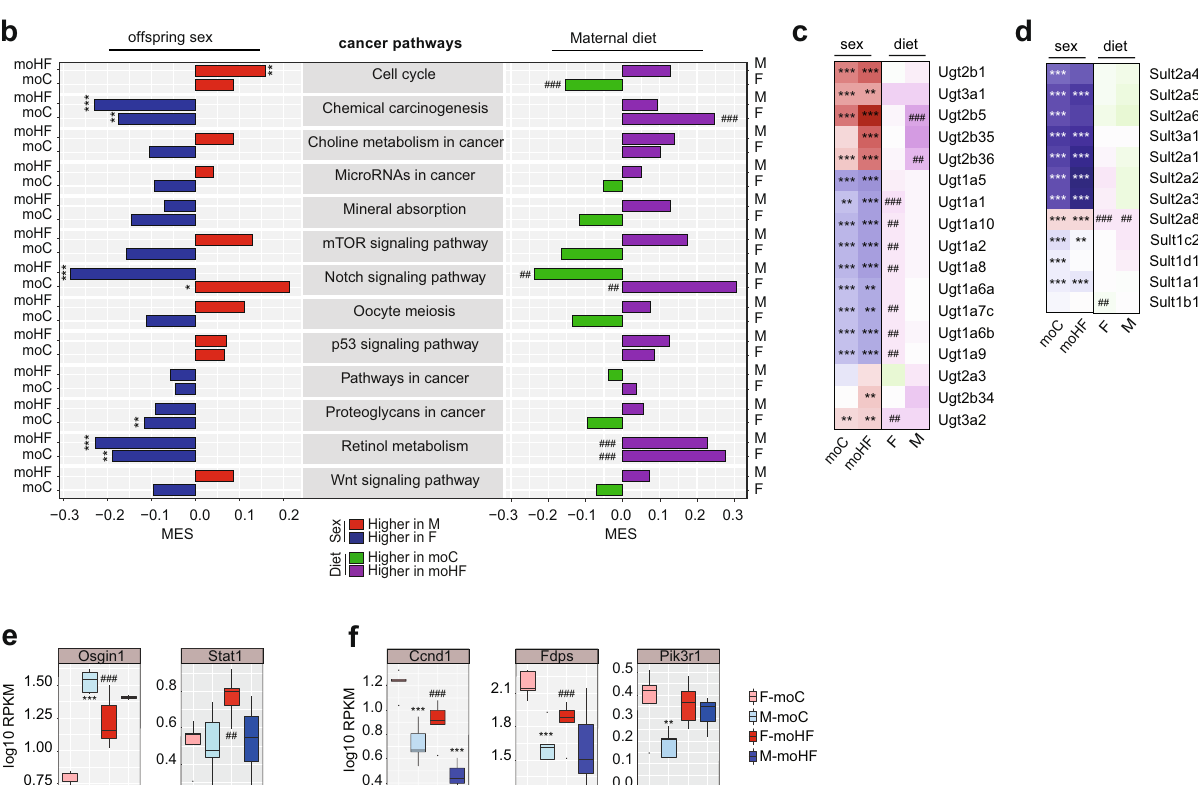
Fig. 5 Maternal obesity has sex-dependent effects on hepatocarcinoma progression in obese offspring. a 10x and 40x hematoxylin-eosin (H&E) images from liver sections of F-moC, M-moC, F-moHF, and M-moHF. b Bar plot presenting the MES between sexes in moC and moHF (left panel) and in response to MO in F and M (right panel) of the KEGG pathways involved in hepatocellular carcinoma. Red and blue bars indicate higher expression in M and F respectively and, green and purple bars indicate higher expression in moC and moHF, respectively. Heatmap of the log2 fold change expression levels of the c Ugt - gene family and d Sult - gene family; e , f Box plots showing expression (RPKM, log10) of genes involved in the nominated cancer pathways. For a , F-moC ( n = 3), M-moC ( n = 3), F-momHF ( n = 4) and M-moHF ( n = 2). For b – f , F-moC ( n = 5), M-moC ( n = 5), F-moHF ( n = 6), and M-moHF ( n = 3). For e , f , data are presented as mean ± sd. Differences between two groups (sexes, F versus M; maternal diet moC versus moHF) were determined by unpaired two-tailed t -test corrected for multiple comparisons using the Holm – Sidak method, with alpha = 5.000%. For pathway and DE genes analysis we used the Benjamini – Hochberg correction with FDR < 0.1, when signi fi cant. *, M versus F and # , moHF versus moC, p < 0.05; ** or ## , p < 0.01; *** or ### , p <